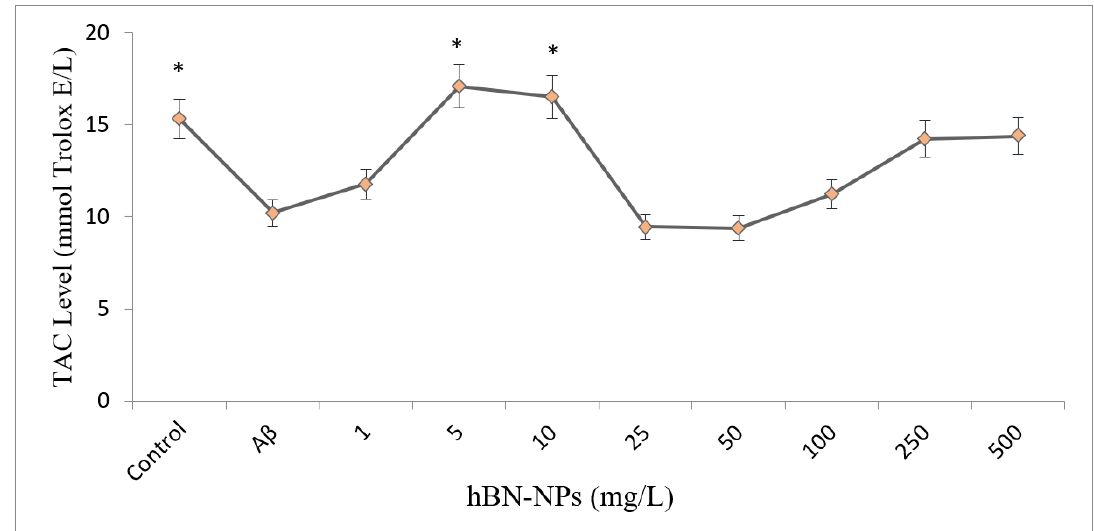
Figure 9. Effects of hBN-NPs and A β treatments on TAC levels in differentiated SH-SY5Y cells. (Control: Cells without hBN-NPs. * Symbol presents significant differences at the p < 0.05 level from the A β group).